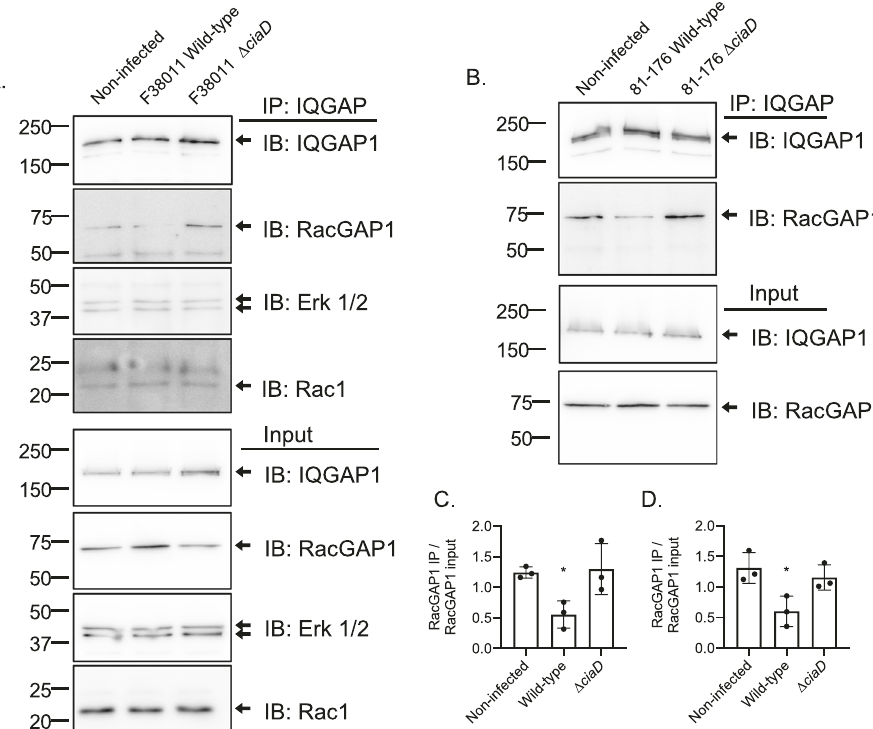
Fig. 5 The CiaD effector protein binds to IQGAP1 to exclude RacGAP1. A IQGAP1 immunoprecipitations (IPs) were performed with INT 407 cells that were non-infected, infected with the C. jejuni F38011 wild-type strain, or infected with the C. jejuni Δ ciaD mutant. Pull-downs were probed by immunoblot (IB) with antibodies for IQGAP1 and RacGAP1. The amount of RacGAP1 in the IQGAP1 complex was reduced during infection with the C. jejuni wild-type strain but not with the Δ ciaD mutant. The amount of Erk 1/2 and Rac1 was not changed. The protein mixture used as the input for the IQGAP1 IPs were also probed for IQGAP1, RacGAP1, Erk 1/2, and Rac1 to determine initial protein abundance. Molecular weights are indicated in kDa. B Similar IQGAP1 IPs were performed with INT 407 cells that were non-infected, and infected with the C. jejuni 81 – 176 wild-type strain. Quantitation of the amount of RacGAP1 in three biologically independent IP experiments indicated that the amount of RacGAP1 in the IQGAP1 complex was reduced approximately 50% during infection with the C C. jejuni F38011 wild-type strain and the (* p = 0.0186) Molecular weights are indicated in kDa. D C. jejuni 81 – 176 wild-type strain. Bars represent the mean and error bars represent the standard deviation; signi fi cant differences from the non-infected samples were determined by ANOVA followed by a two-tailed Dunnet ’ s multiple comparisons test (* p =